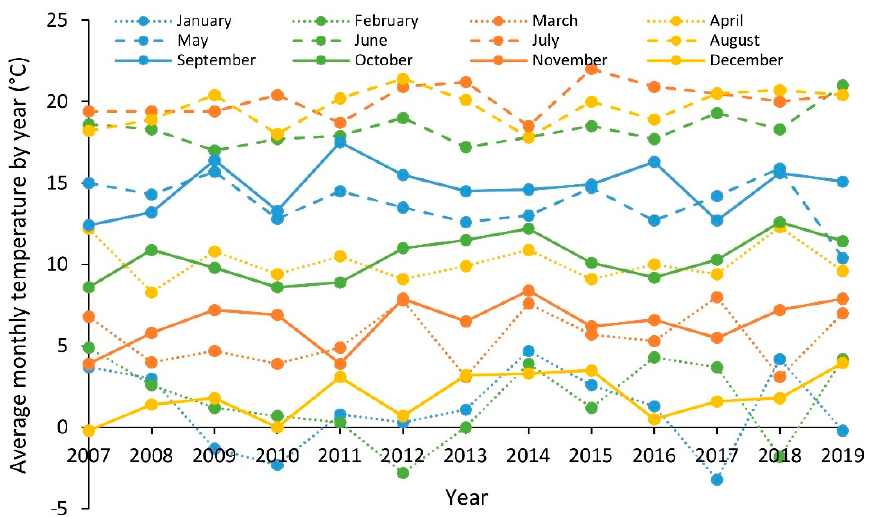
Figure 3. Average monthly air temperatures at the Postojna weather station (obtained from http://www.meteo.si/).